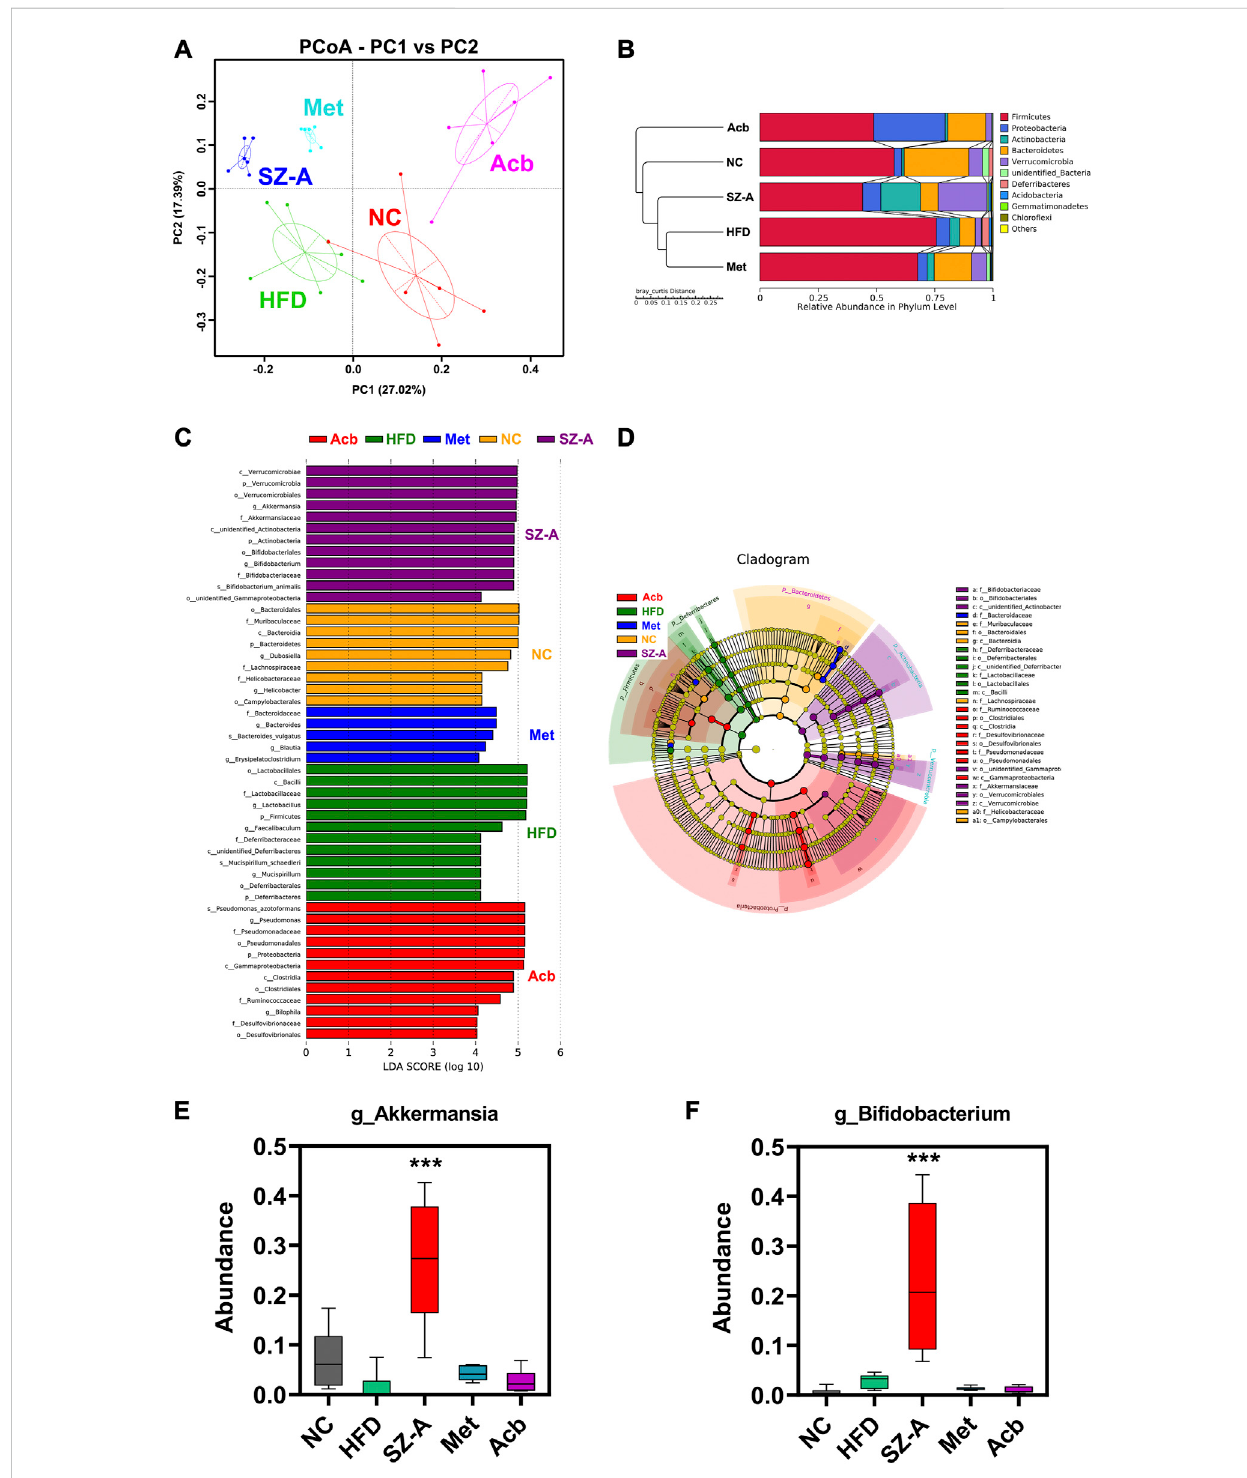
FIGURE 3 SZ-A altered the gut microbiota structure in HFD-induced obese mice through beta diversity analysis. (A) PCoA, Principal Co-ordinates Analysis. (B) UPGMA, Unweighted Pair-group Method with Arithmetic Mean. (C) LEfSe, LDA Effect Size. (D) LEfSe, branching diagram. (E) The abundance of Akkermansia muciniphila at the genus level ( n = 6). (F) The abundance of Bi fi dobacterium at the genus level ( n = 6). Each value is expressed as mean ± SEM. *** p < 0.001 compared with